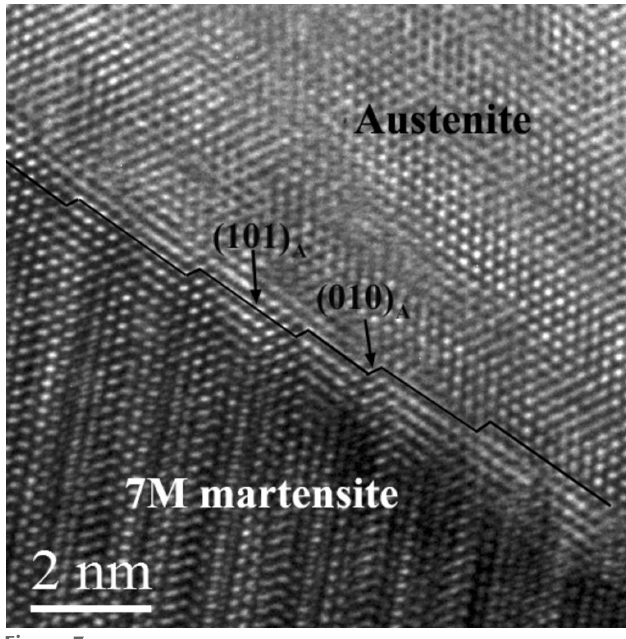
Figure 7 A high-resolution TEM image of the austenite–7M martensite interface. The incident beam is along h 1 1 (cid:5) 1 i A .